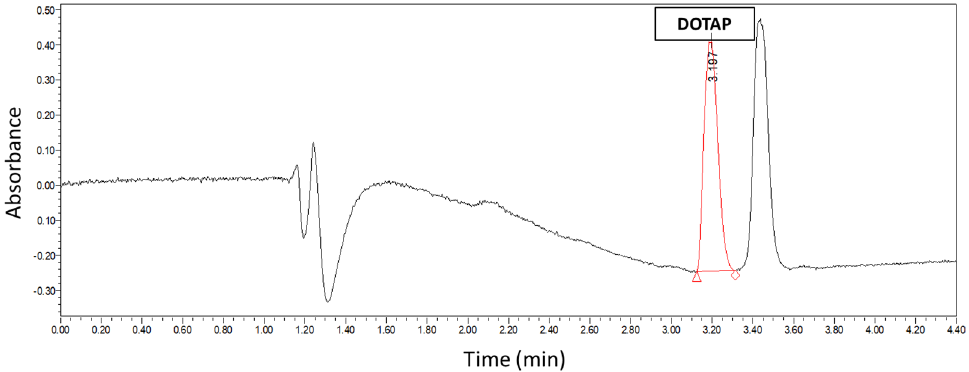
Figure 3. U-HPLC chromatograph of DOTAP4 sample. DOTAP peak in red and DOPE peak to the right. Liposome concentration was calculated by measuring the AUC of DOTAP peak.